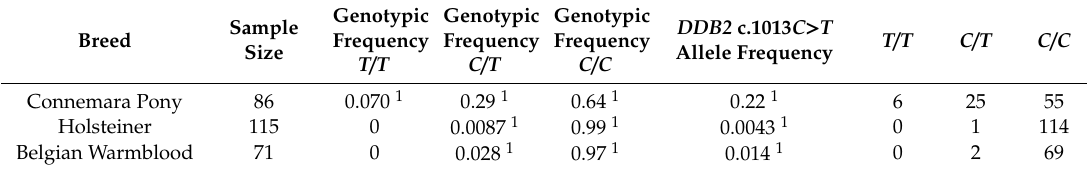
Table 4. DDB2 c.1013 C > T allelic frequencies and genotypic frequencies in the Connemara pony and Holsteiner